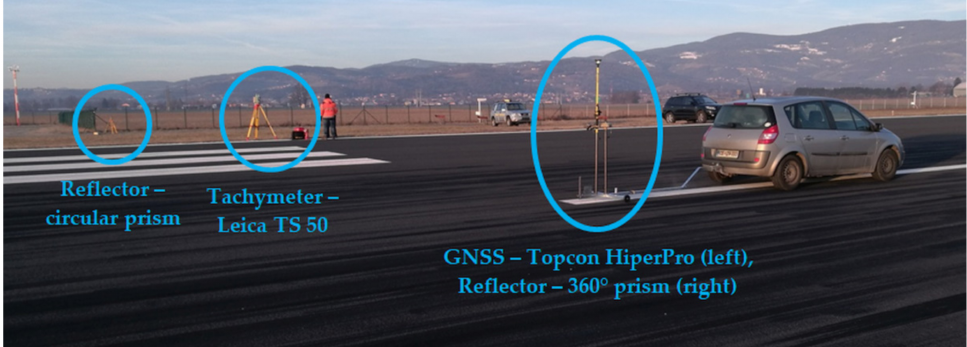
Figure 1. Measuring equipment and non-spring made trailer.